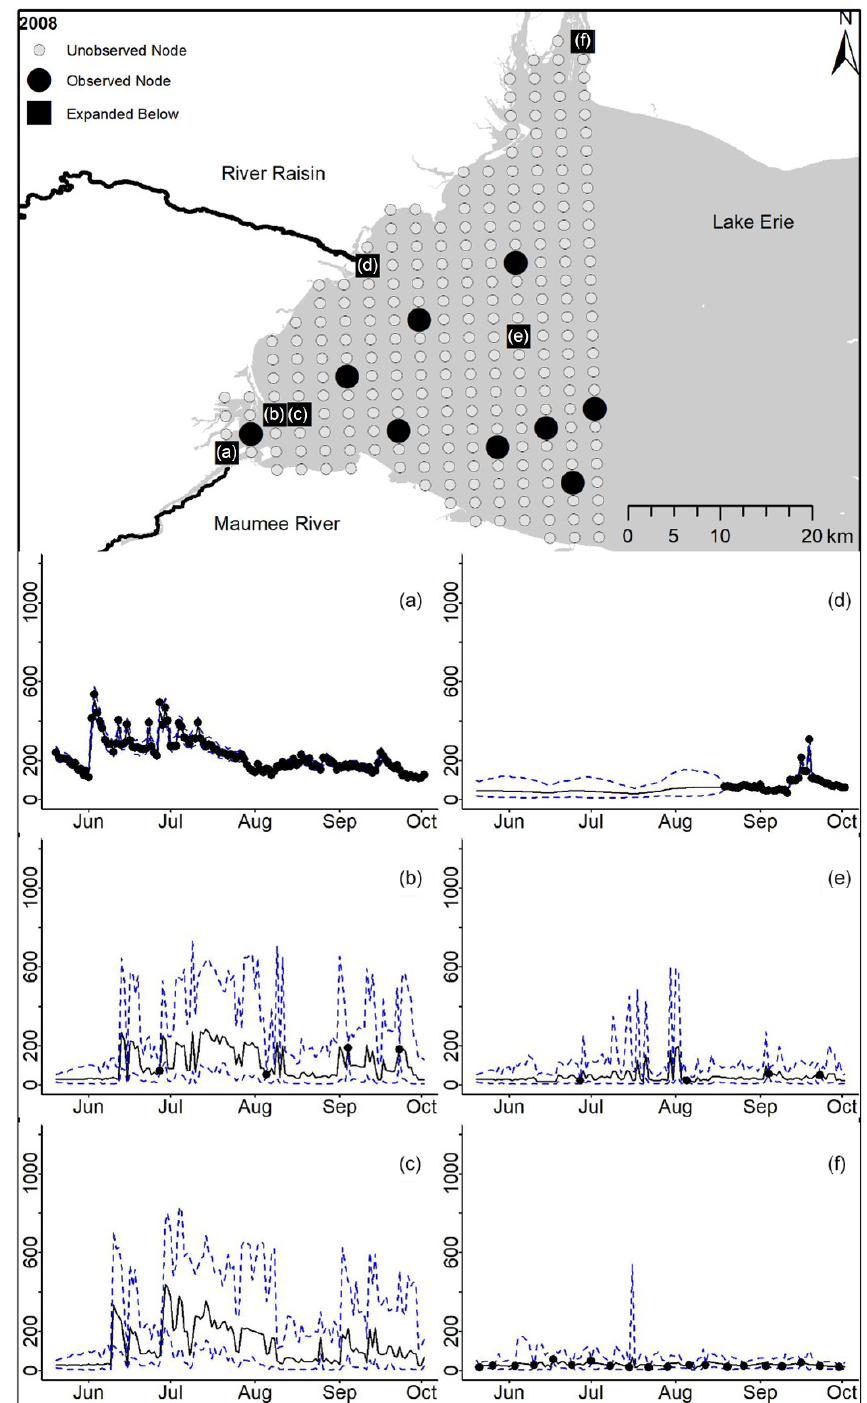
Figure D1. For 2008 the total phosphorus concentrations (µgL − 1 ) at observed and unobserved nodes were estimated from the model posterior samples. Mean (solid black line) and 95%PI (dashed blue line) for the model posterior samples of each node at every day for (a) the Maumee River, (b, c, e, f) western Lake Erie nodes, and (d) the Raisin